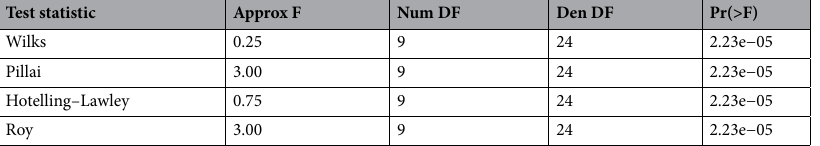
Table 1. Four MANOVA approximate F statistics (approx F), the numerator degrees of freedom (num DF), the denominator degrees of freedom (den DF), and the P-values (Pr(>F)) used to test for differences among fitted coefficients in the fPCA-based mixed effects